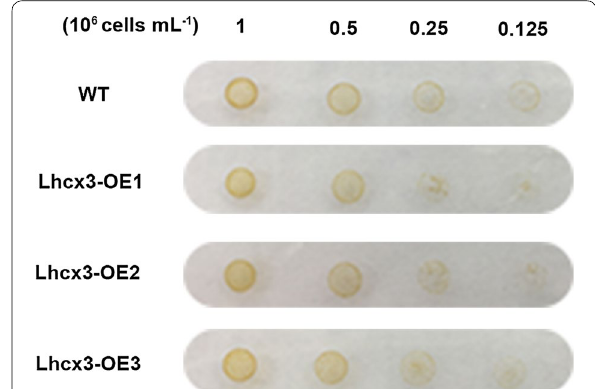
Fig. 7 Growth tests on cells spotted on solid f/2 media. A total of 5 μL of cell dilutions (1, 0.5, 0.25, and 0.125